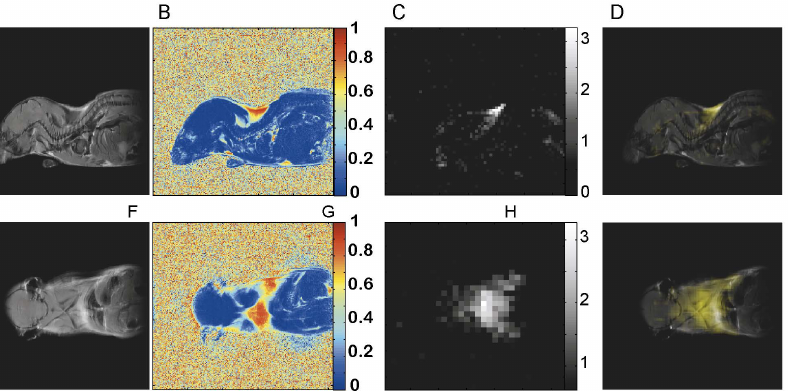
Figure 5. Comparison between BATSCI maps and fat fraction maps for the detection of BAT. ( A ) Anatomical sagittal spin echo MR image of a young C57 mouse. ( B ) Fat fraction map of the same animal. ( C ) BATSCI map showing the interscapular brown fat depot. ( D ) BATSCI map overlaid on spin-echo image, illustrating the intrascapular BAT depot. ( E ) Anatomical coronal spin echo MR image of the same animal. ( F ) Coronal Fat fraction map of the same animal. ( G ) BATSCI map showing the interscapular brown fat area. ( H ) BATSCI map overlaid on spin-echo image, illustrating the intrascapular BAT depot.